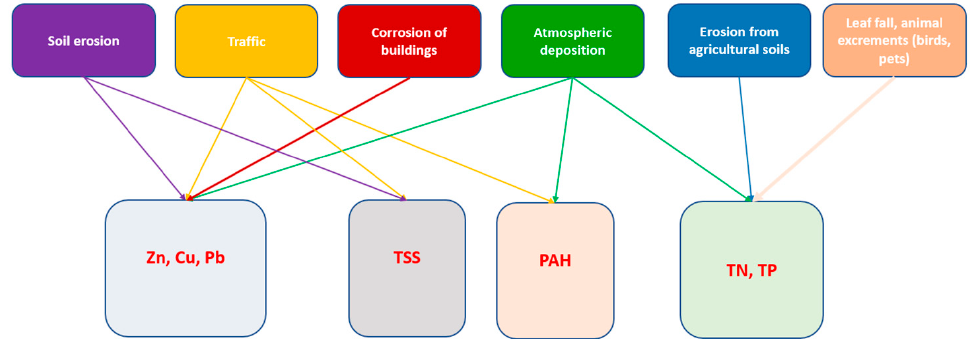
Figure 1. Pollutant sources in the aquaSens